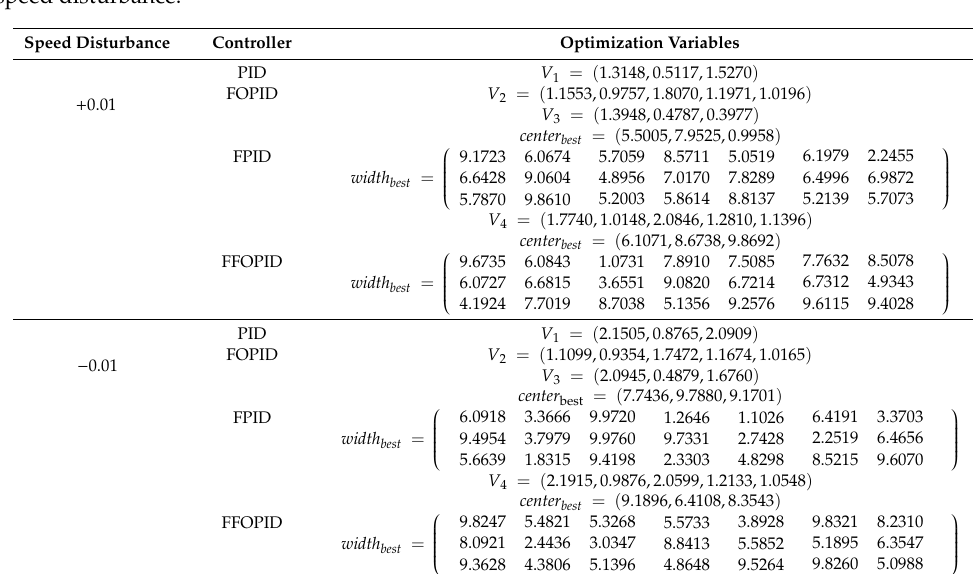
Figure 9. Pareto optimal solutions obtained through MOGSA for speed disturbance of +0.01 and −0.01 under 526 m low water head. Table 6. Optimal parameters of controllers for pumped storage unit regulating system under rotational speed